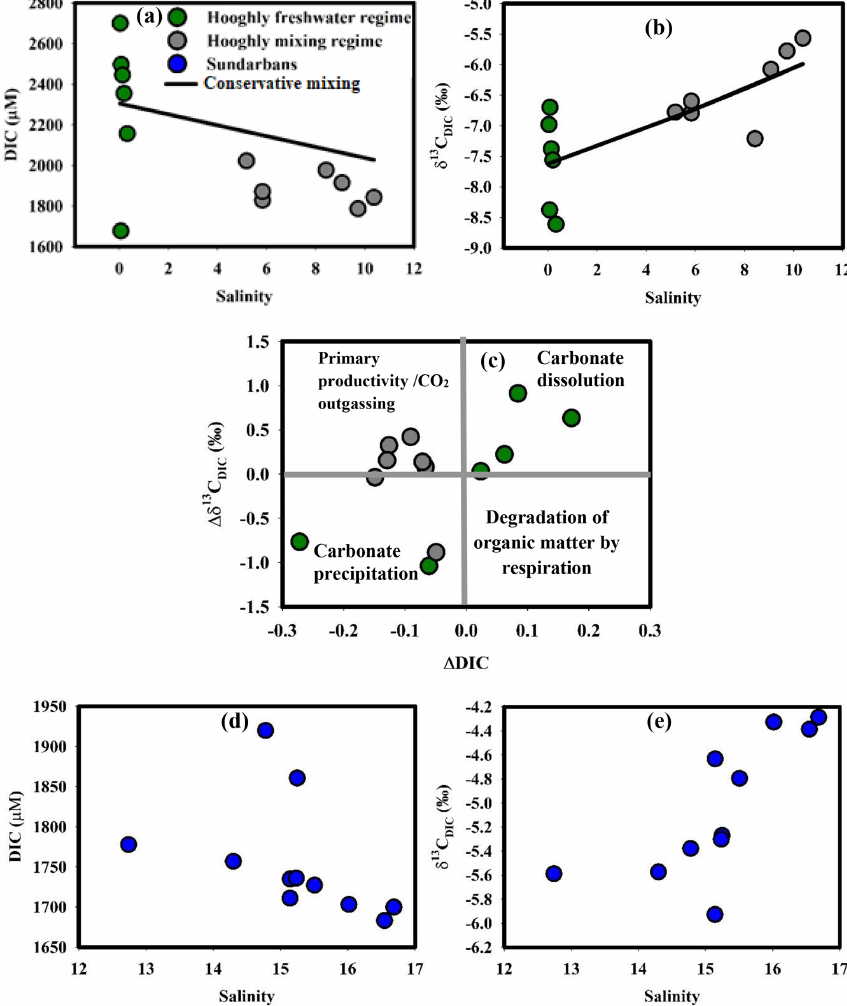
Figure 3. (a) DIC–salinity in the Hooghly, (b) δ 13 C DIC –salinity in the Hooghly, (c) (cid:49) DIC– (cid:49)δ 13 C DIC in the Hooghly, (d) DIC–salinity in the Sundarbans and (e) δ 13 C DIC –salinity in the Sundarbans.